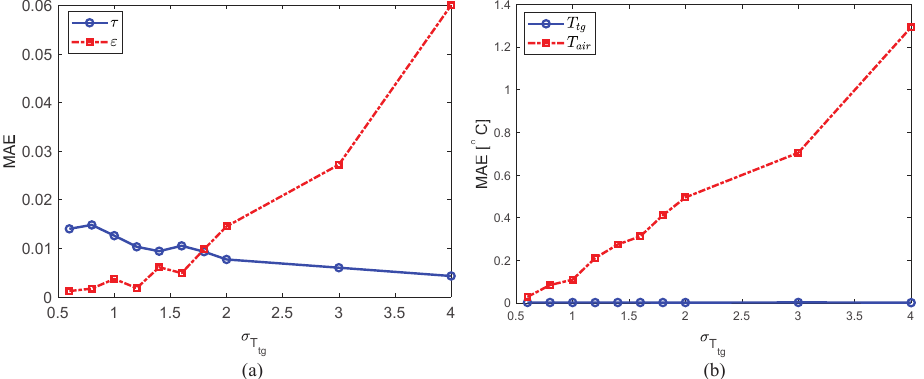
Figure 18. Parameter separation performance according to object temperature noise ( σ T of τ , ε , and ( b ) MAE of T tg , T air